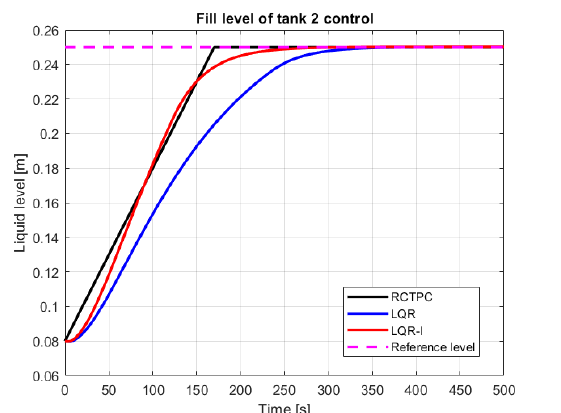
Figure 4. Control process of the filling of the second tank (source: